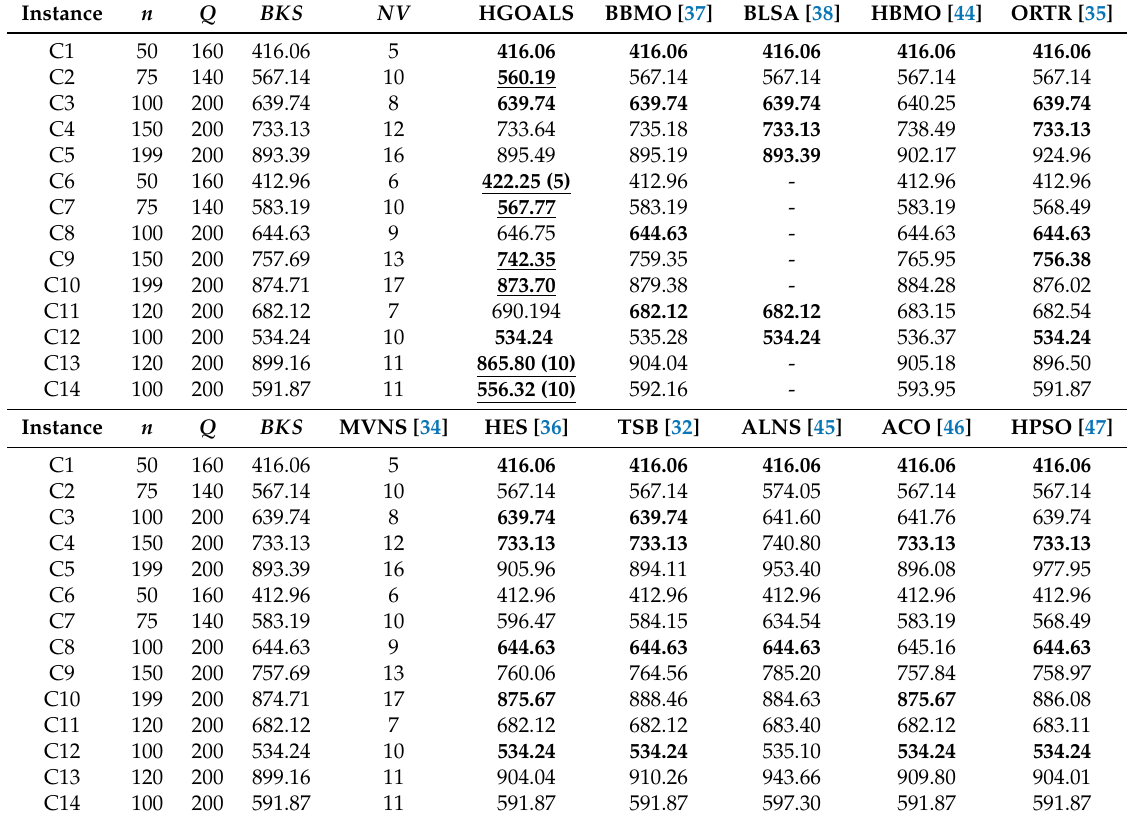
Table 3. Comparison between the HGOALS results and previous research for instances in group C (hierarchical objective